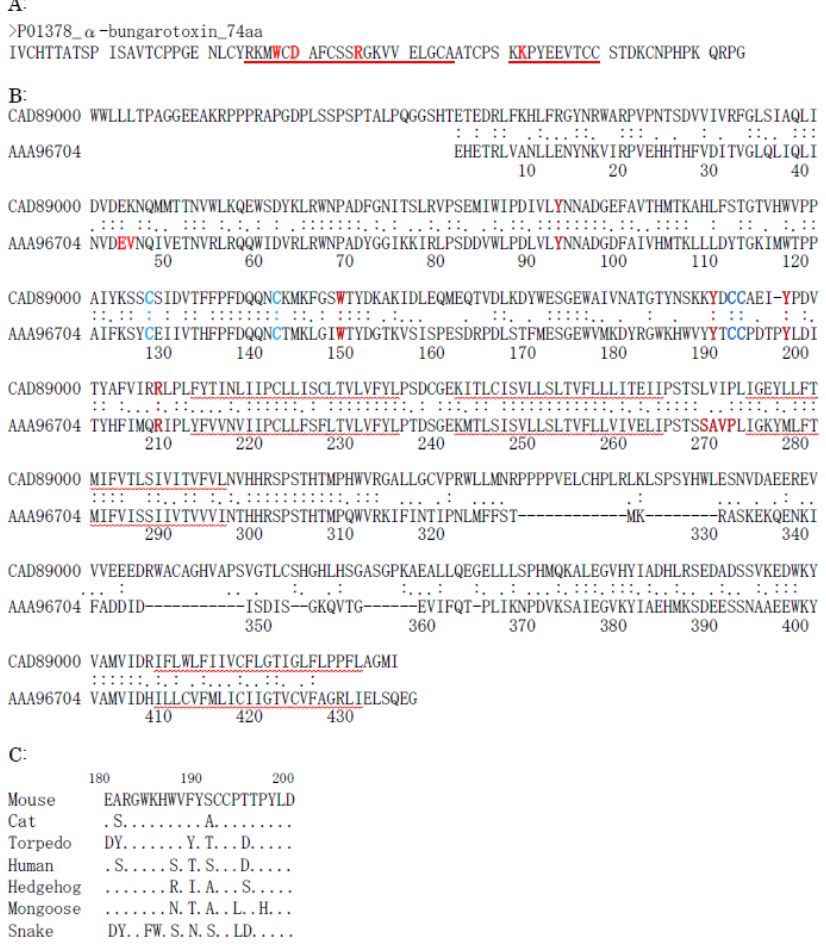
Figure 2. ( A ) Amino acid sequence of α-bungarotoxin (GenBank accession No. P01378). Amino acids involved in the binding to thr acetylcholine receptor are marked with bold red. Red underlines indicate loop II and loop III, respectively. ( B ) Comparison of amino acid sequences of human α2-acetylcholine receptor (GenBank accession No. CAD89000) and Torpedo marmorata α-acetylcholine receptor (GenBank accession No. AAA96704). Amino acid residues involved in the ligand-binding are marked with bold red. Wavy red underlines show the trans-membrane regions. ( C ). Comparison of critical amino acid residues of acetylcholine receptors from species that are sensitive or resistant to α-bungarotoxin. Dots indicate the same amino acid residues as that of a mouse.